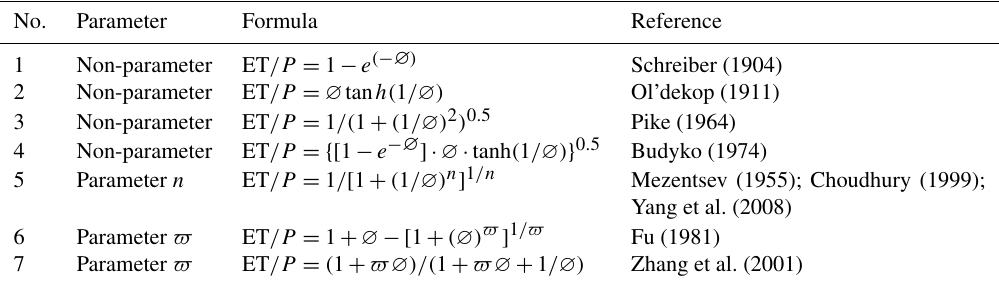
Table 1. Different formulas of Budyko curves. Note that the aridity index is expressed as ∅ = PET /P . No.